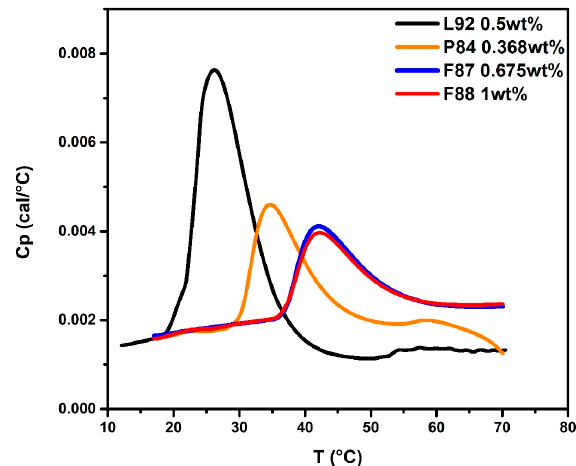
Figure 7. The HSDSC thermograms of pure Pluronic F88, F87, P84, and L92 system. 1.0 wt % F88, red line; 0.675 wt % F87, blue line; 0.368 wt % P84, orange line; and 0.5 wt % L92, black line.